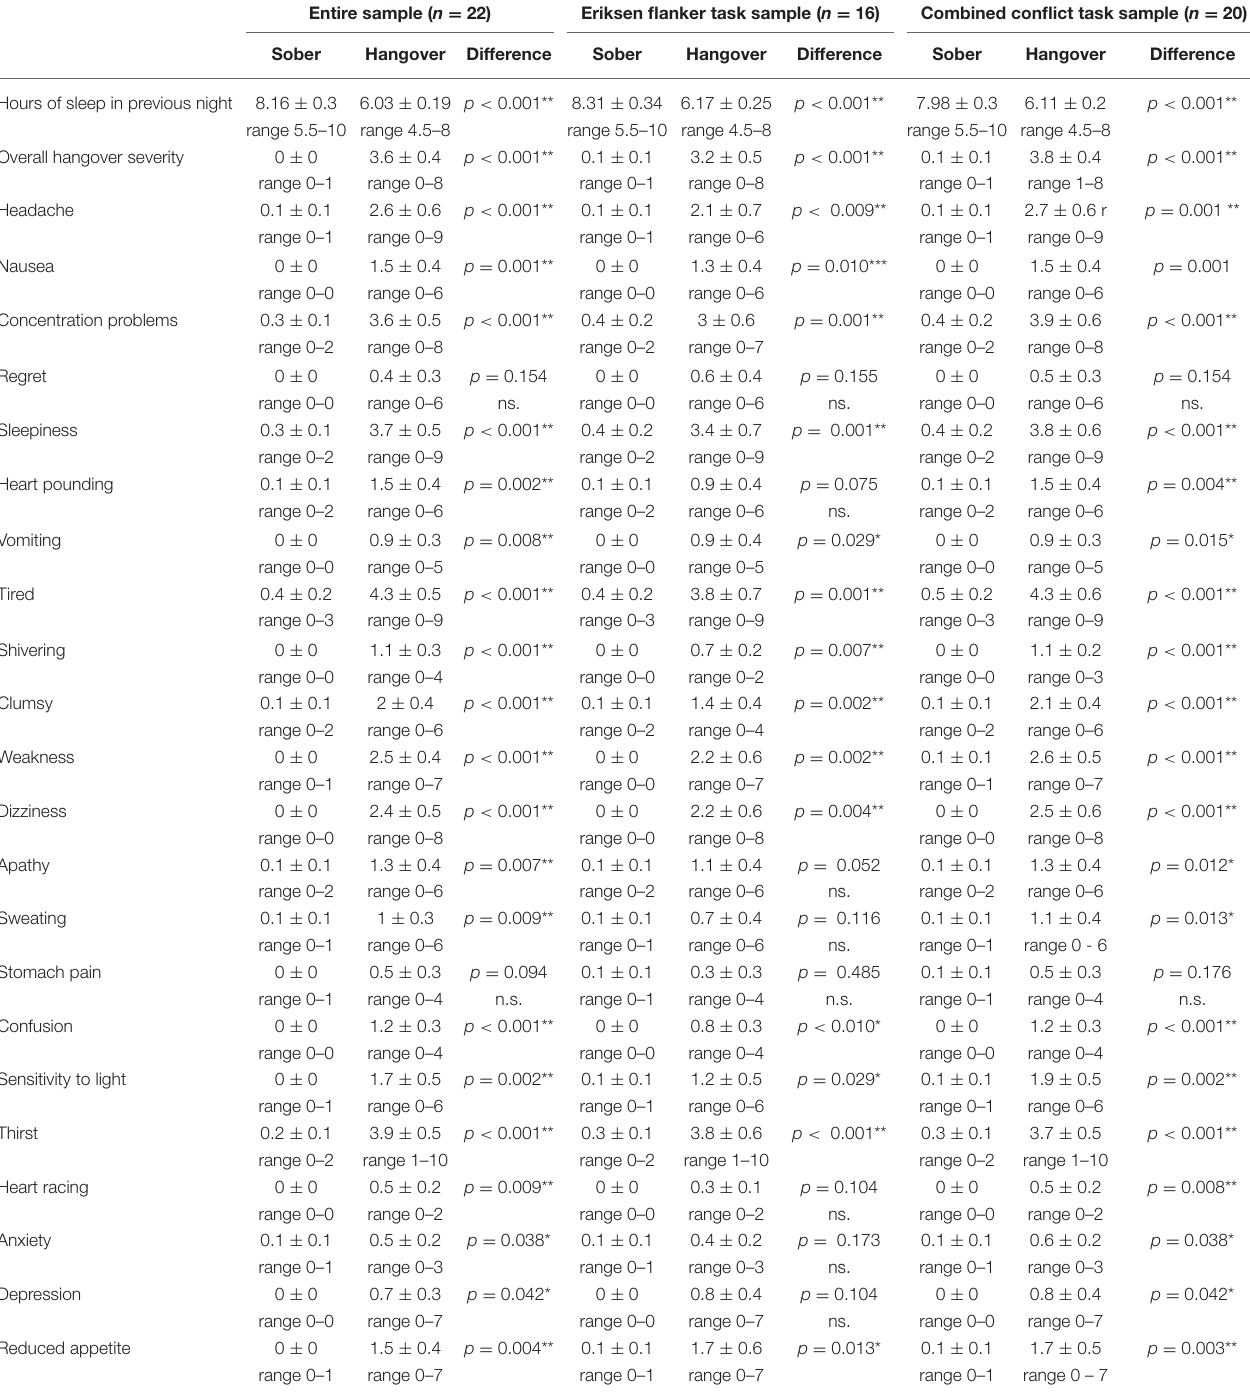
TABLE 2 | Sleep and hangover symptoms on both